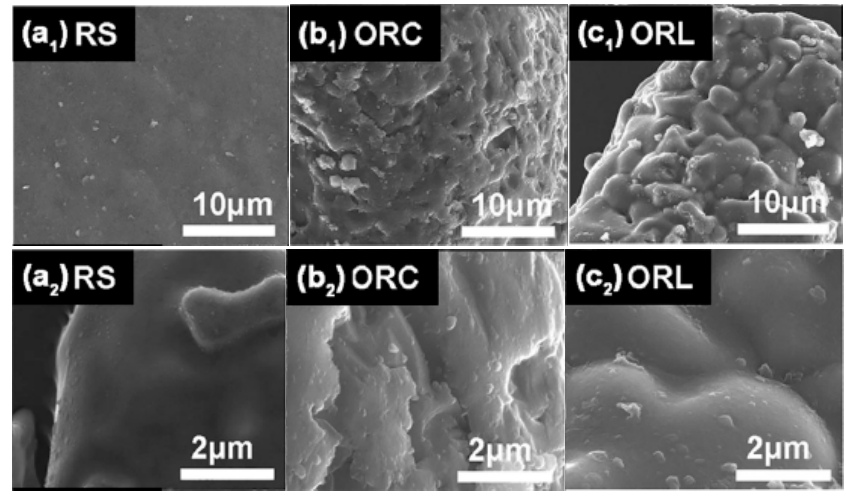
Figure 10. SEM images of three kinds of Li 4 SiO 4 materials prepared with Li 2 CO 3 (RS), lithium acetate (ORC) and lithium lactate (ORL) [19].